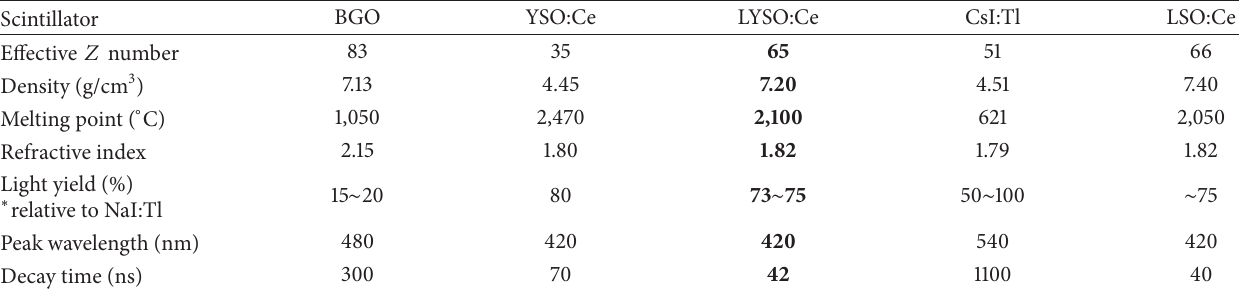
Table 1: Main characteristics of inorganic scintillators [11].